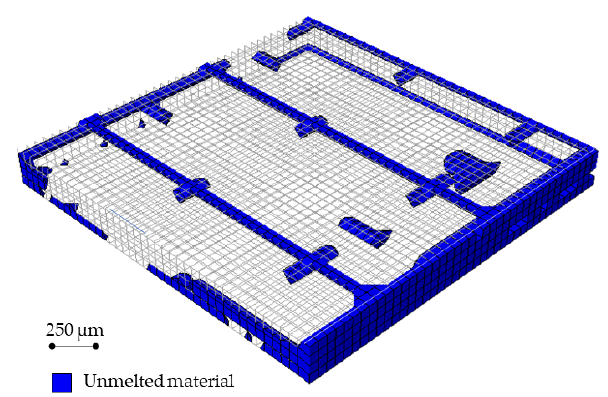
Figure 6. Simulation of a process condition that causes the appearance of a lack of fusion. The translucent elements indicate the material that achieved the melting point during the process (ID=1), while blue ones indicate the material that has never achieved the melting point (ID=0). After the cooling phase, the unmelted material during the process represents a lack-of-fusion defect in the final part.